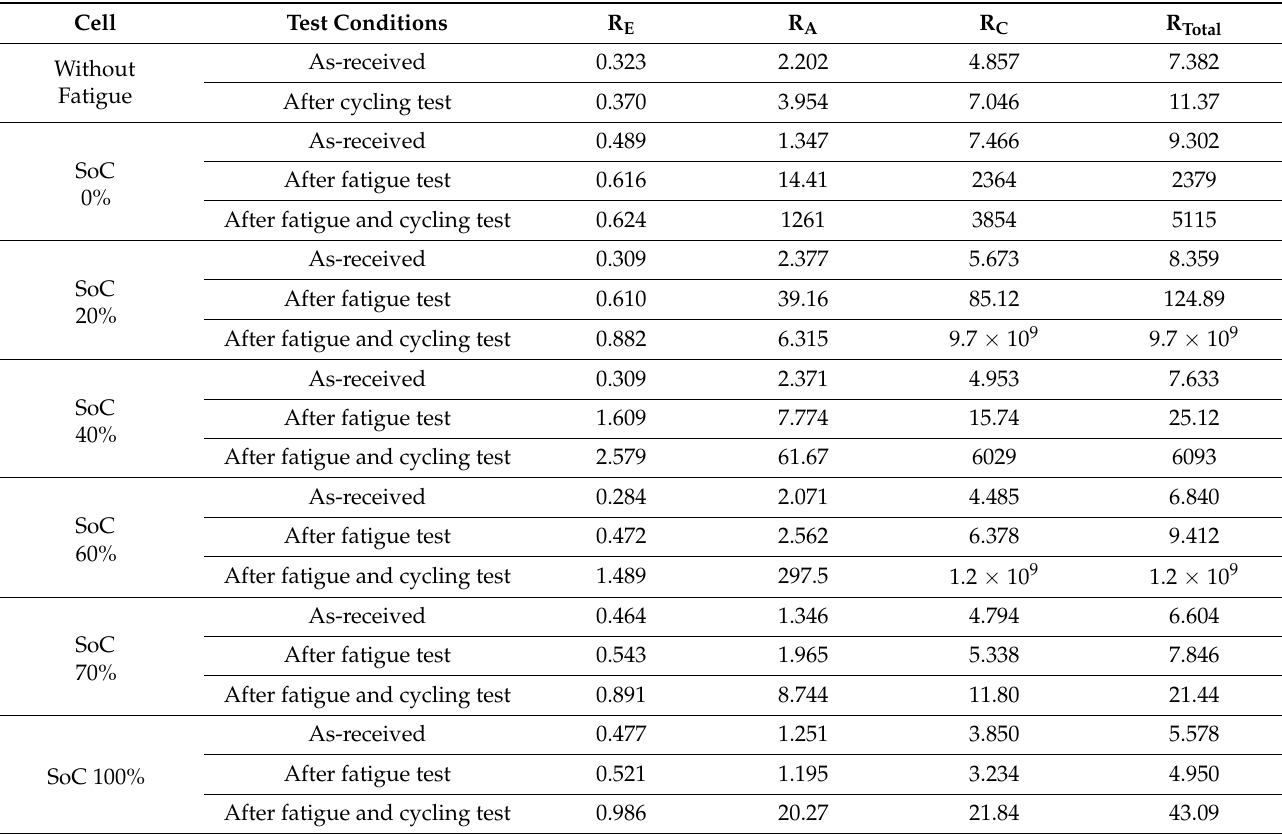
Table 1. Electrolyte resistance (R E ), anode resistance (R A ), cathode resistance (R C ), and total resistance (R Total ) for the different SoC cells under the conditions of as-received, after the fatigue test, and after the fatigue and cycling test. The resistance unit is Ω .